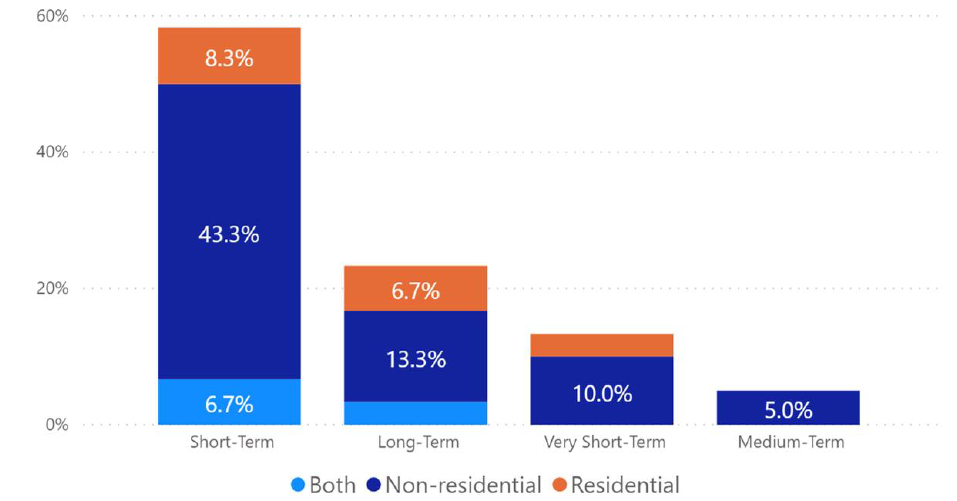
Figure 7. Comparison between building type and prediction horizon.